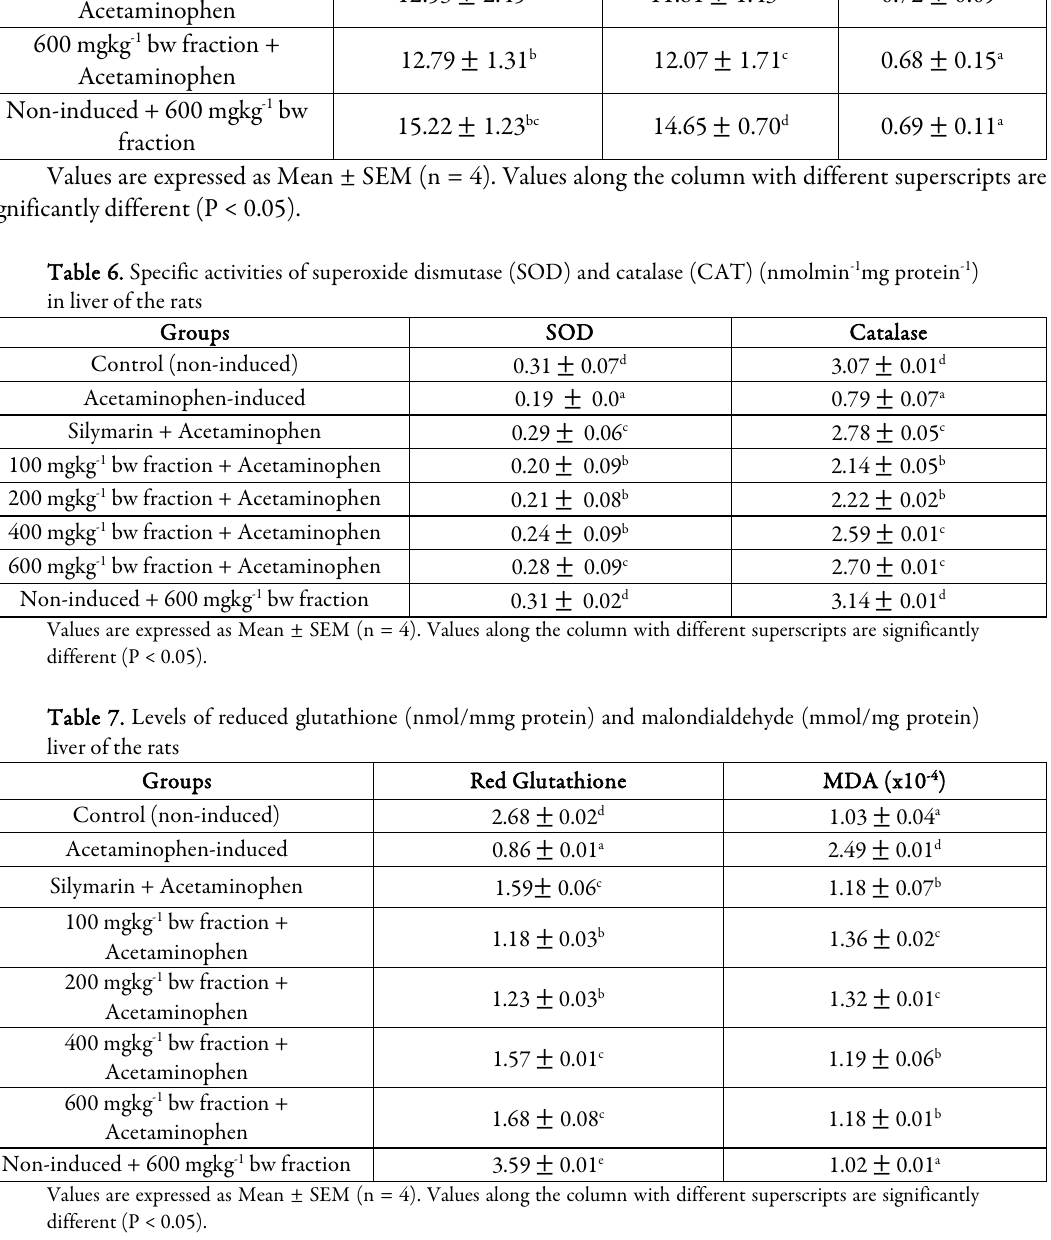
Values are expressed as Mean ± SEM (n = 4). Values along the column with different superscripts are significantly different (P <